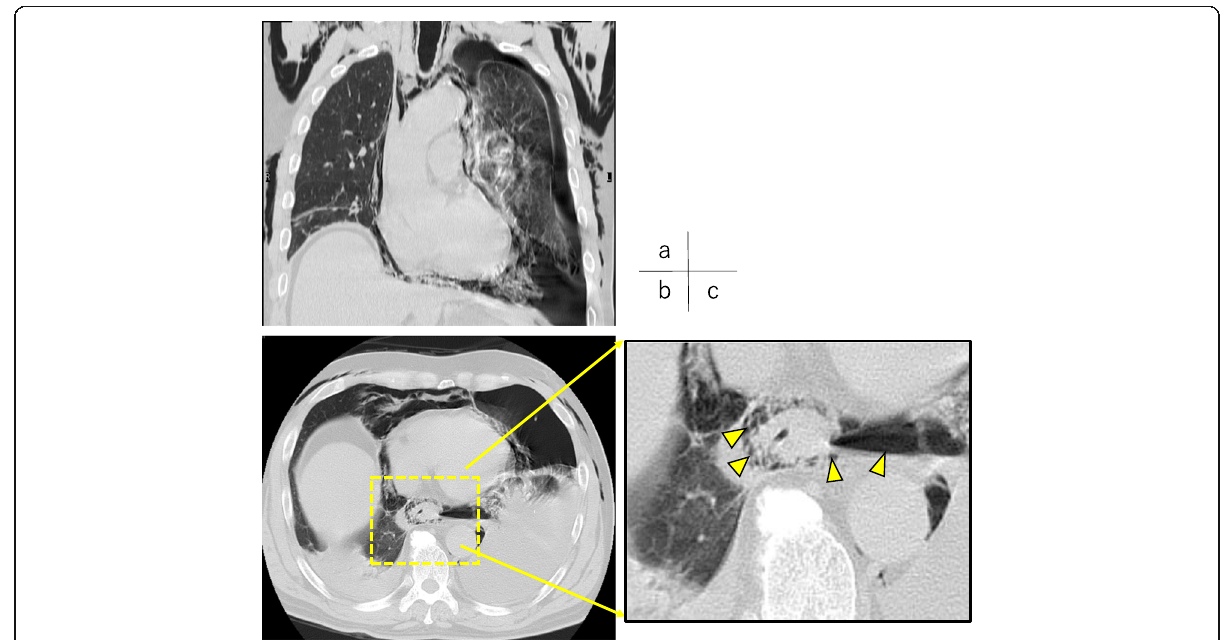
Fig. 1 Preoperative chest CT findings. Chest CT revealed left tension pneumothorax ( a ) and pneumomediastinum around the lower esophagus (arrowheads) ( a – c ). a Transverse section. b Lower esophagus. c Enlarged view of the lower